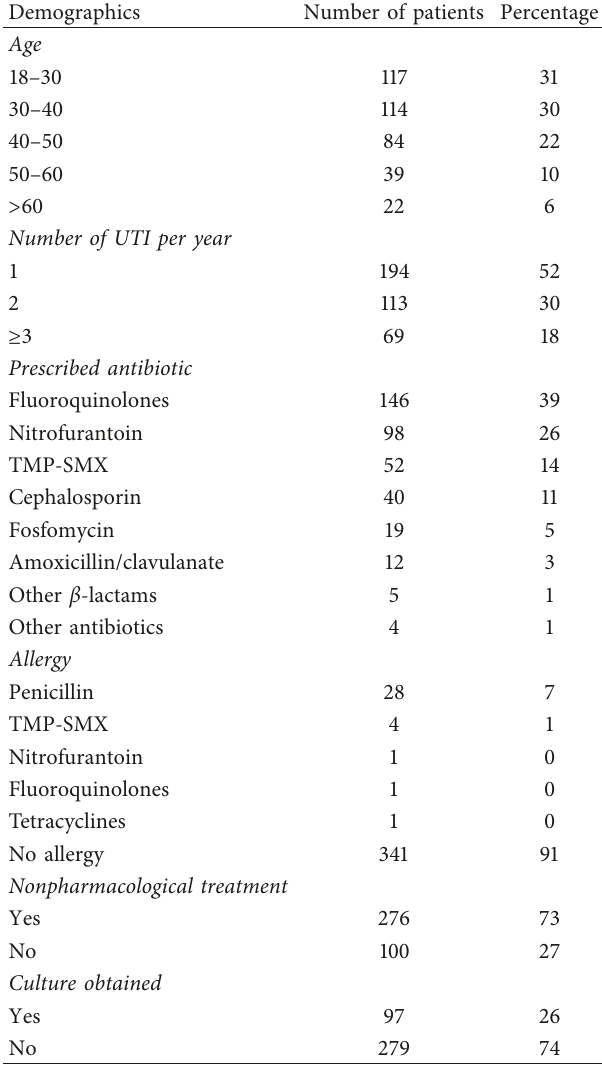
Table 1: Baseline